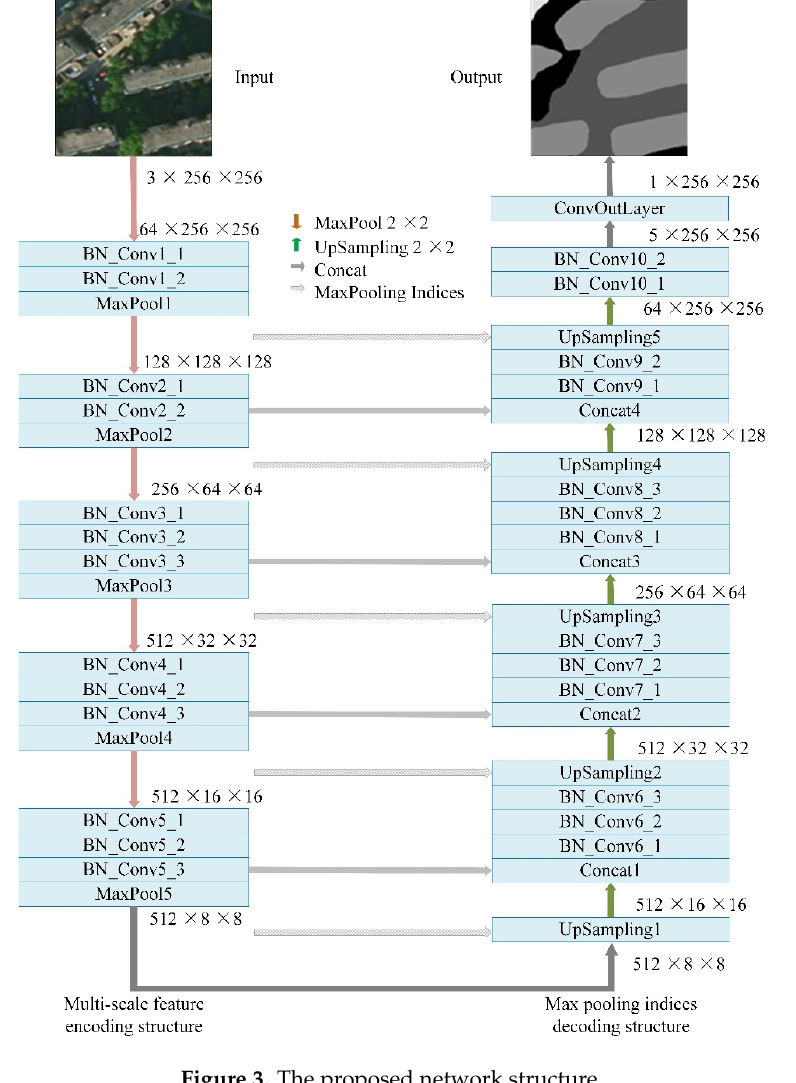
Figure 3. The proposed network